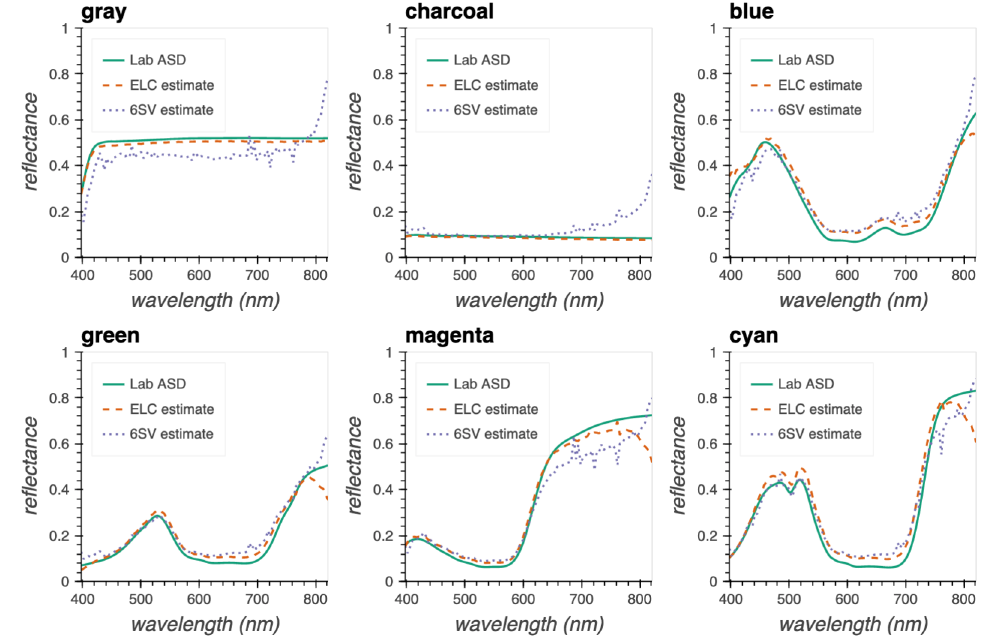
Figure 17. Calibration tarp spectra with ELC and 6SV reflectance